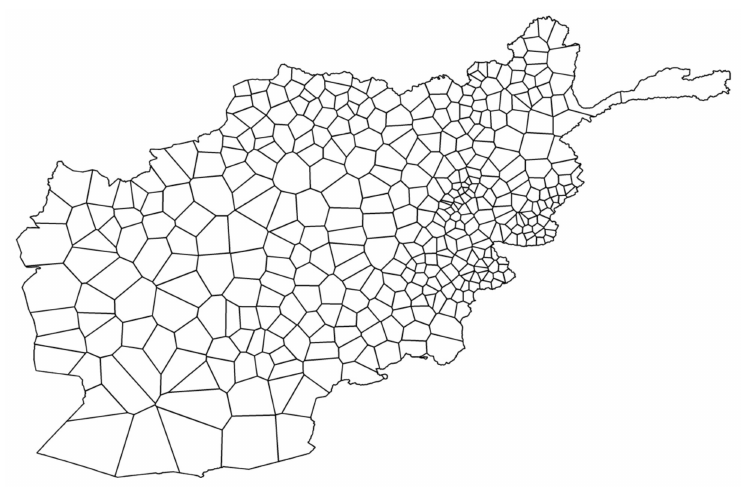
Figure 4. Visualization of irregular cellular automata neighborhoods for Afghanistan’s 400